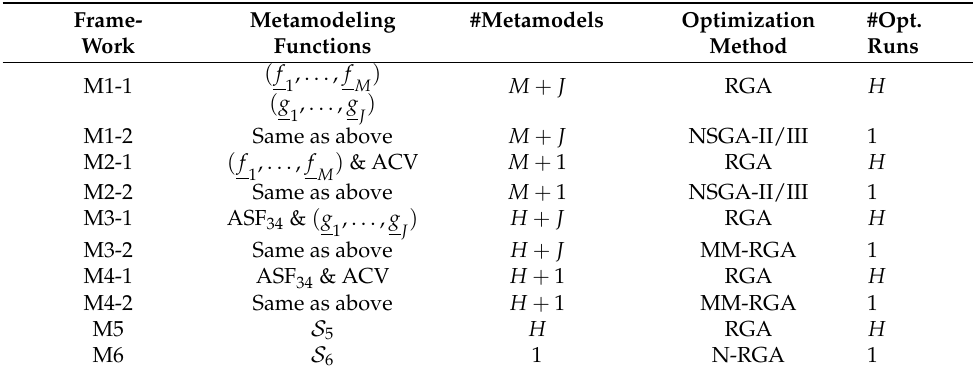
Table 1. Summary of metamodeled functions and optimization algorithms needed in each epoch for all 10